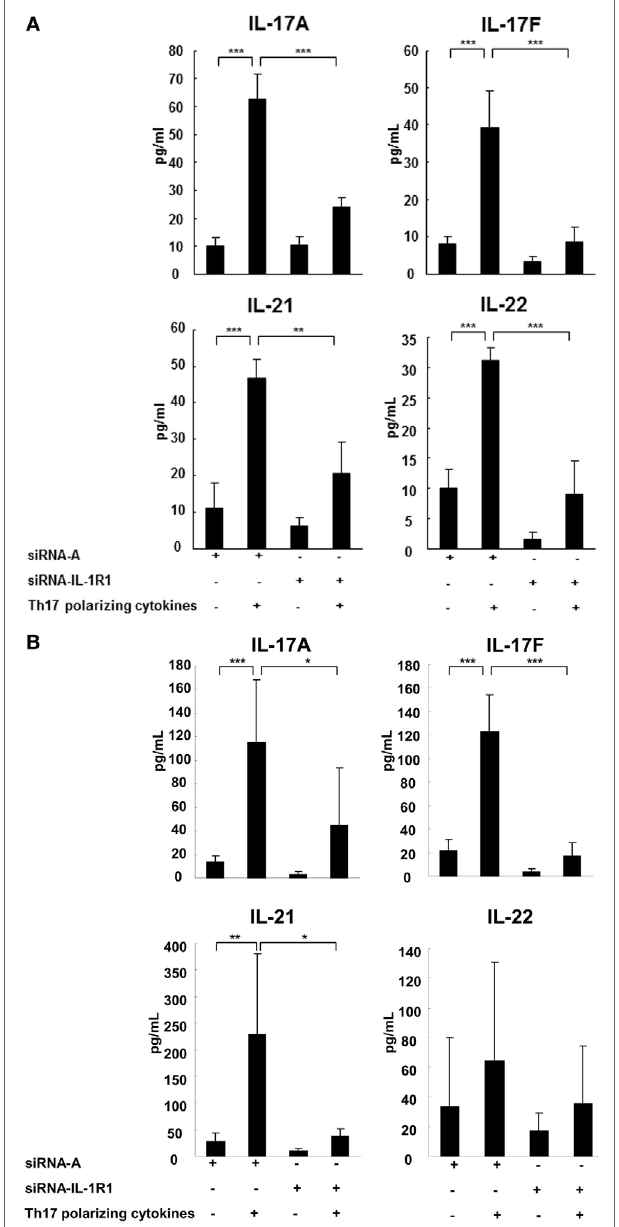
FigUre 4 | il-1r1 signaling induces secretion of Th17 cytokines . CD4 + CD45RA + cells were derived from three HCs (a) and three RR MS patients (B) , transfected with a control siRNA A or siRNA IL-1R1, stimulated with plate-immobilized anti-CD3 and anti-CD28 mAb and cultured in serum-free medium in the absence or presence of Th17-polarizing cytokines. After 72 h, the supernatants were collected and the cytokine production measured by ELISA. Statistical analysis was performed using a repeated measures ANOVA, * p < 0.05, ** p < 0.01, *** p <